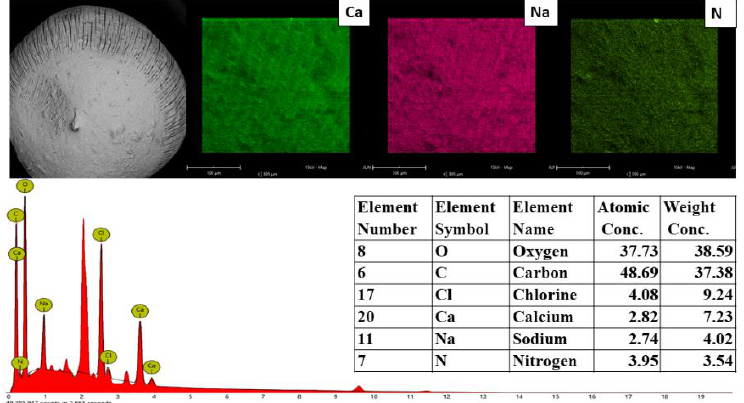
Figure 4. EDX maps of B-PE-20%.